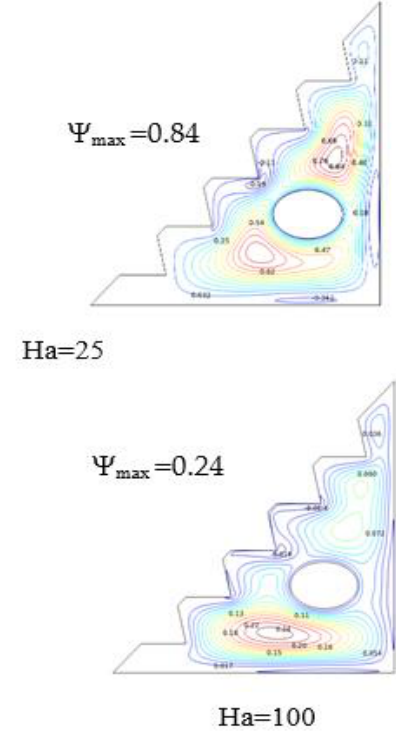
5 , w = 0, and φ = Figure 7. Streamlines for Ra = 10 5 , w = 0, and ϕ = 0.02. Figure 7. Streamlines for Ra = 10